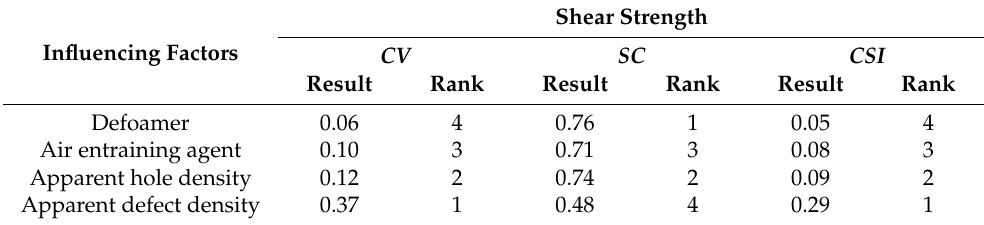
Table 10. Comparison of fuzzy evaluation value of influencing factors of shear strength of SCFFC.